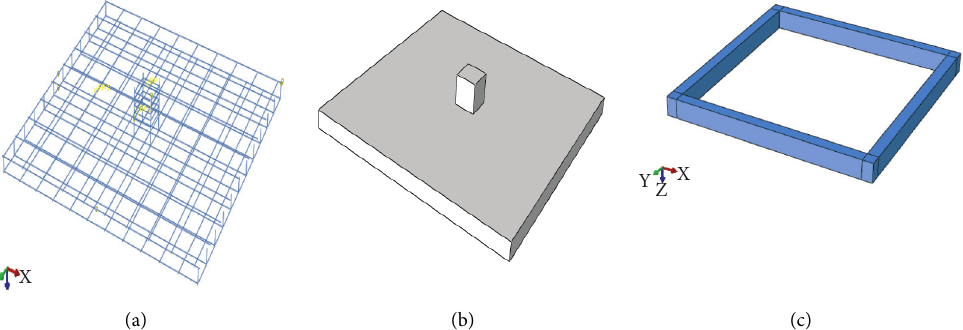
Figure 3: Different components of slab. (a) Longitudinal and transverse reinforcement. (b) Concrete slab and column. (c) Slab support.